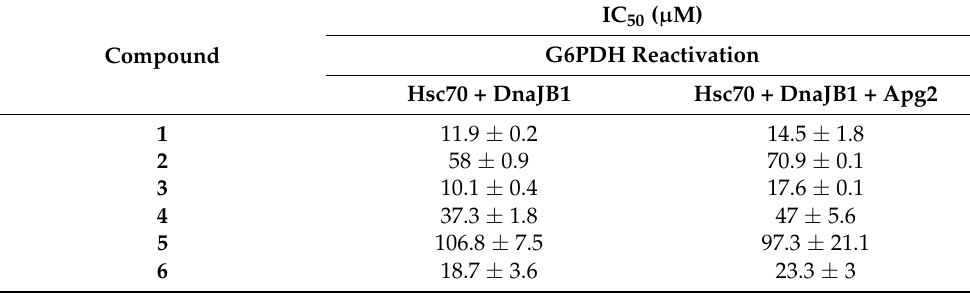
Table 2. IC 50 values estimated for the inhibition of the aggregate reactivation ability of binary and ternary chaperones mixtures by the selected compounds. Values are means ± SD of three independent